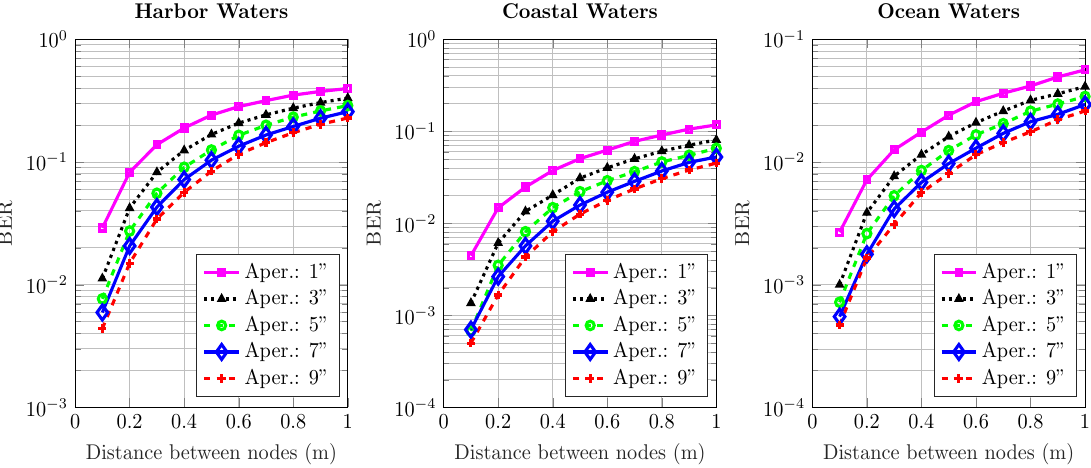
Figure 8. Effect of increasing transmission distance and aperture on the BER performance of harbor, ocean, and coastal waters for 45 ◦ receiver FoV.